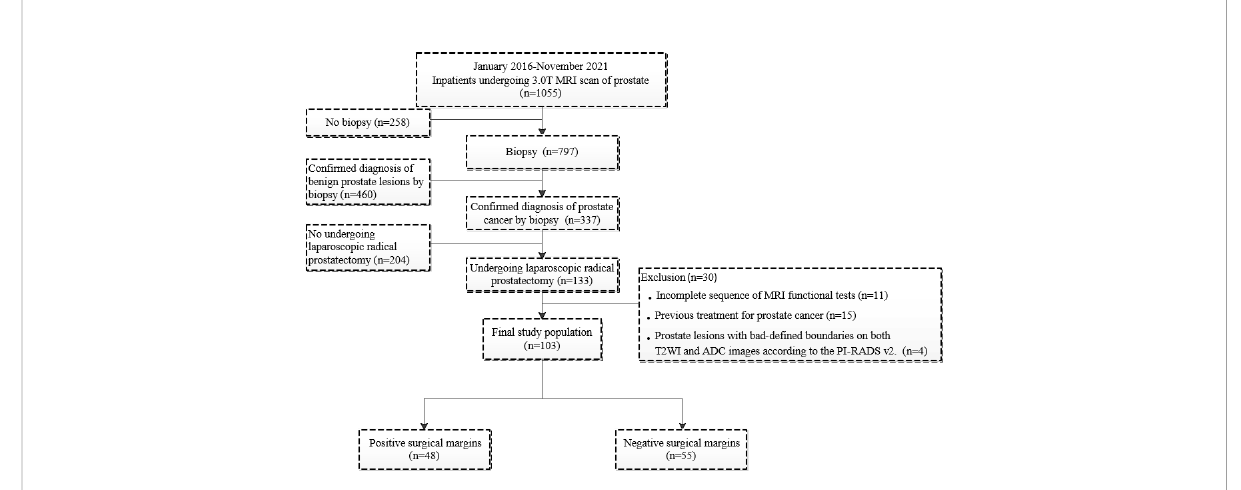
FIGURE 1 Flowchart of the patient